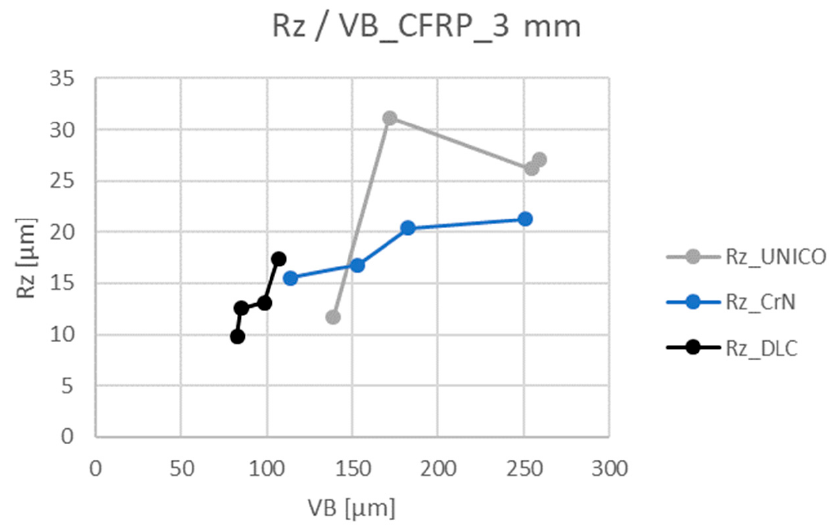
Figure 20. Dependence of the surface roughness parameter R z on wear, laminate thickness 3 mm. R z —maximum height of profile. VB—flank wear.